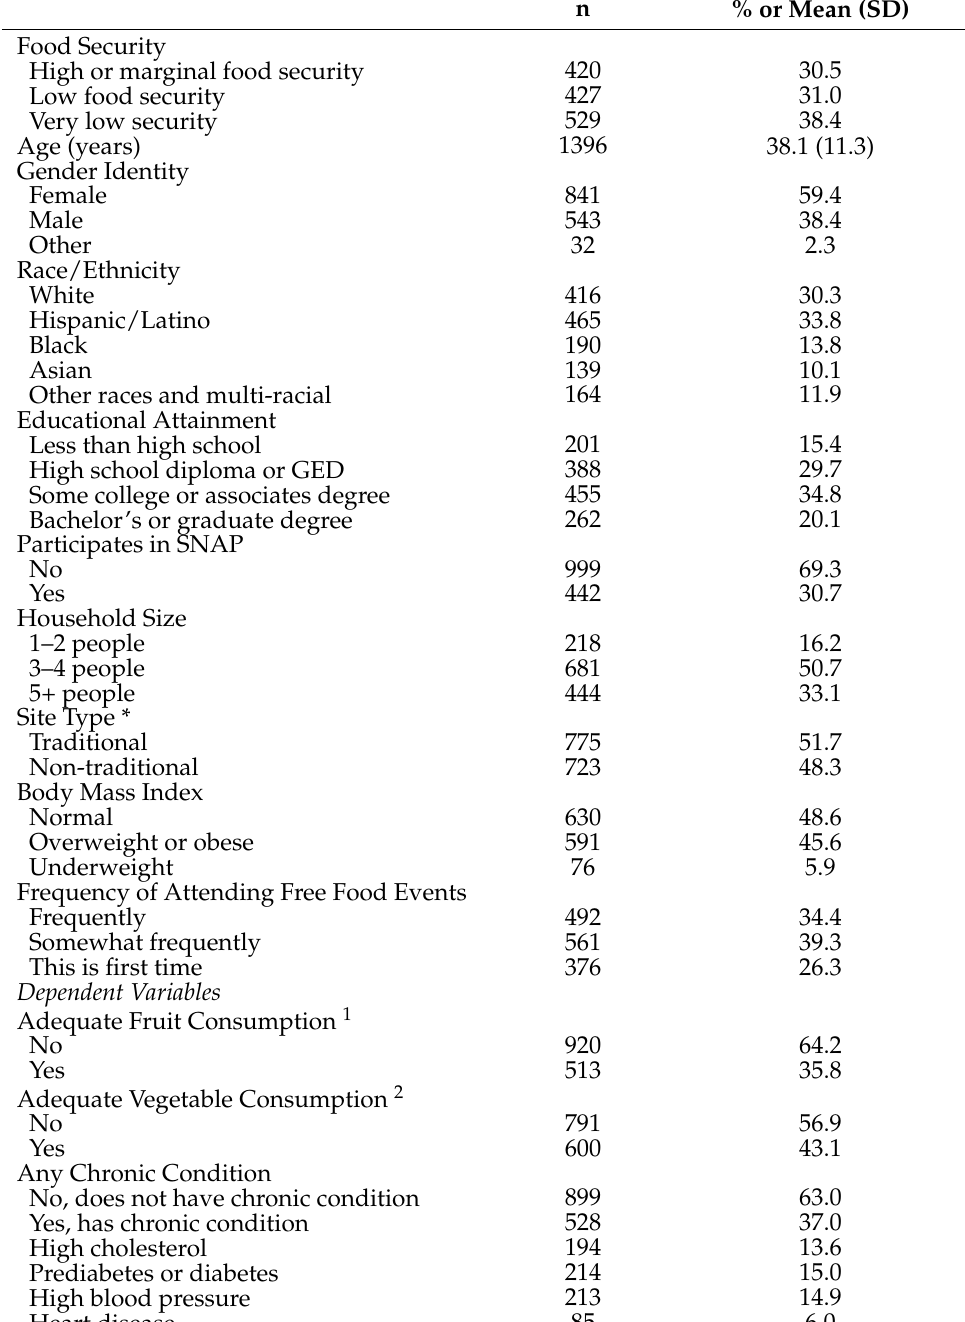
Table 1. Survey participant demographics and health-related characteristics, Los Angeles County, California, 2021 ( n = 1498).